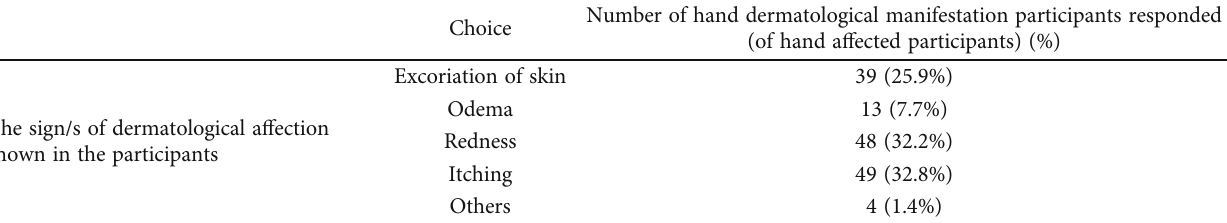
Table 8: The sign/s of the dermatological manifestation shown in the 907 participants.